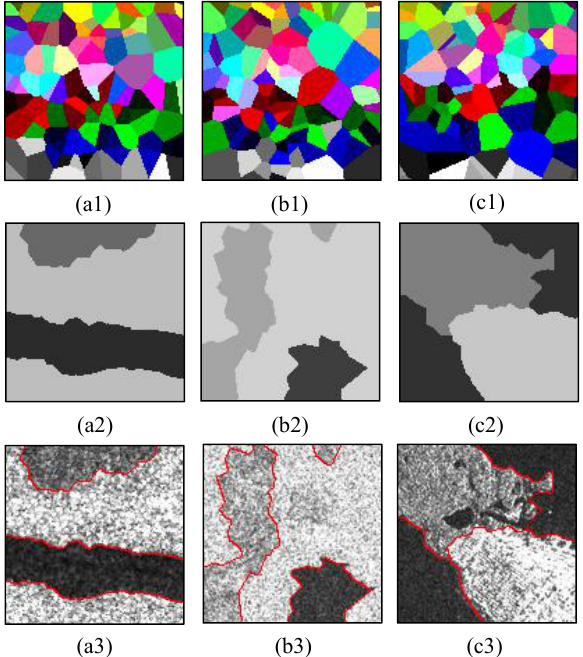
Figure 5. Segmentationo results with the proposed algorithm for real SAR